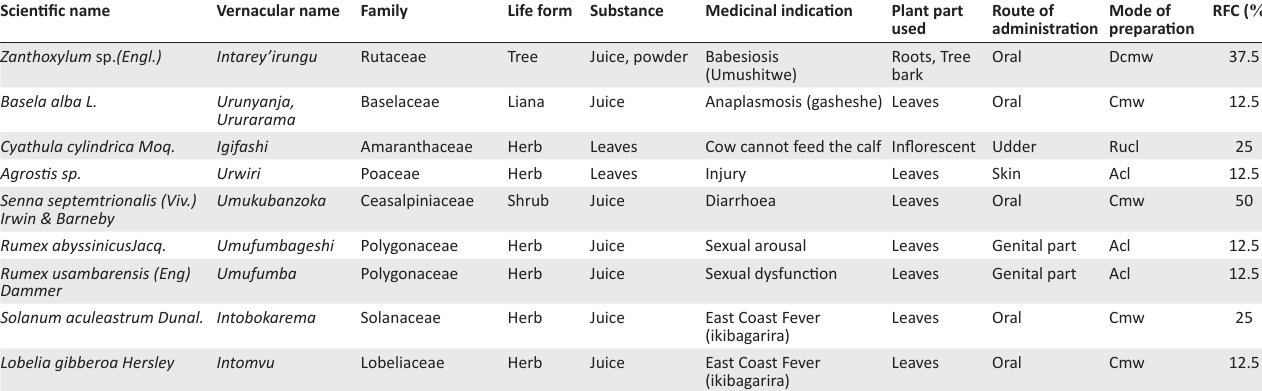
TABLE 4: Plants used in veterinary medicine.